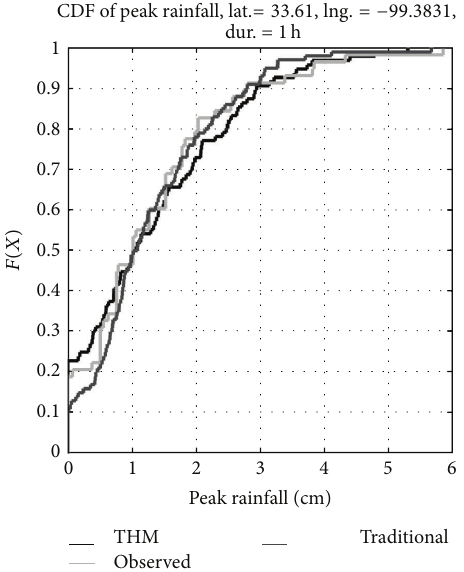
Figure 9: The empirical cumulative density function of the monthly peak rainfall depth made from the rainfall time series generated by THM, the traditional approach of MBLRPM, and